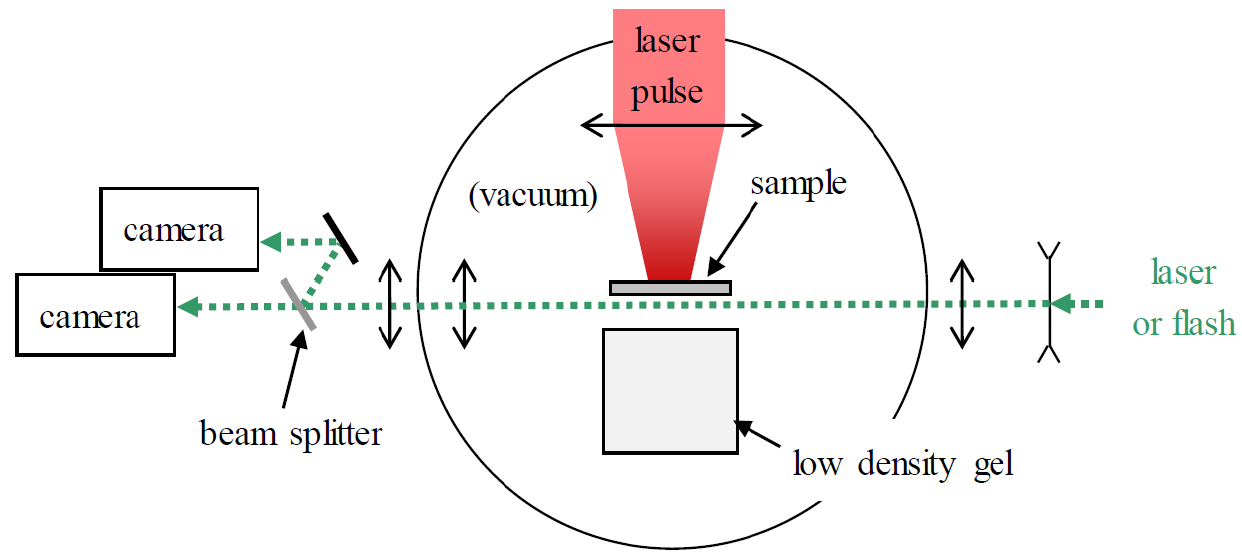
Figure 2. Schematic of the experimental